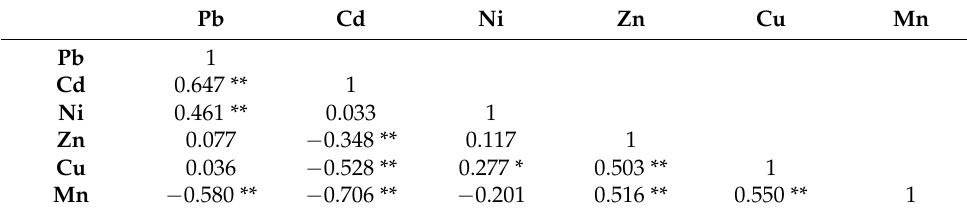
Table 7. Pearson correlation among heavy metals in Chalan beel area.